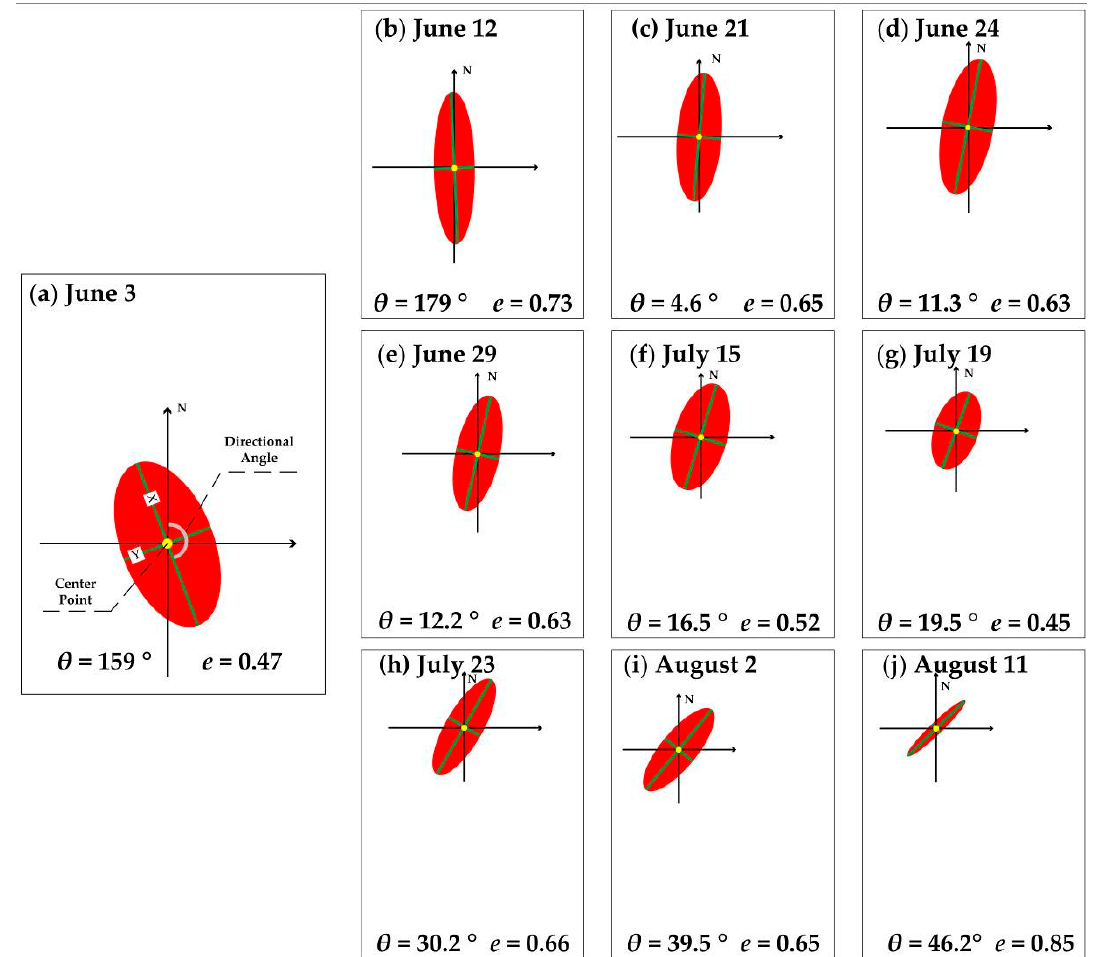
Figure 9. Standard deviation ellipse of the coverage area of U. prolifera in 2018. The first standard deviation ellipse was used in this paper, containing the data with a ratio of 68% (the proportion of data contained does not affect the values of two key indicators). ( a ) The SDE on June 3. ( b ) The SDE on June 12. ( c ) The SDE on June 21. ( d ) The SDE on June 24. ( e ) The SDE on June 29. ( f ) The SDE on July 15. ( g ) The SDE on July 19. ( h ) The SDE on July 23. ( i ) The SDE on August 2. ( j ) The SDE on August 11. Four parameters of the standard deviation ellipse are marked in ( a ). The yellow round dot is the elliptical center point, and the two green lines passing through the center point and perpendicular to each other are the X-axis and Y-axis, respectively. The angle between the north direction and the long axis is the directional angle, which is represented by an orange arc in the diagram. The annotation of these parameters is omitted from other subgraphs. The direction and oblateness of the ellipse are indicated at the bottom of each subgraph. θ represents the direction angle, whereas e is the oblateness.